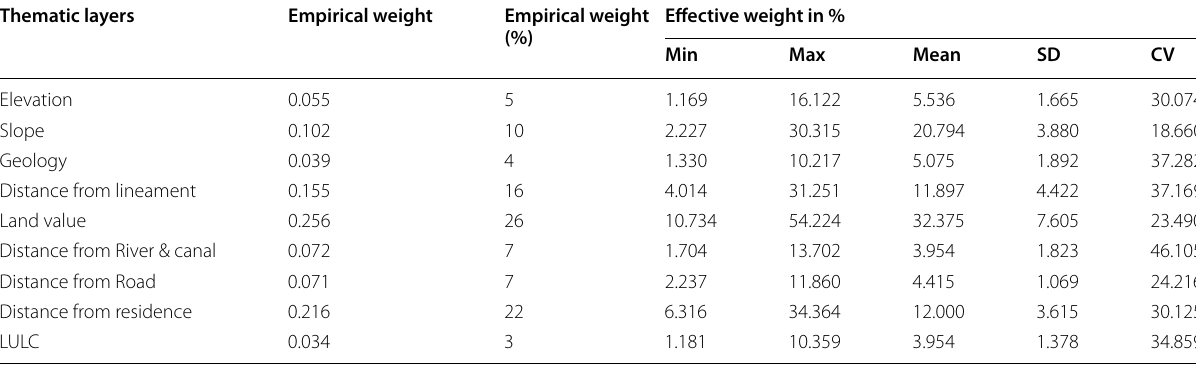
Min Minimum, max Maximum, SD Standard deviation, CV Coefficient of variation Source: Computed by the